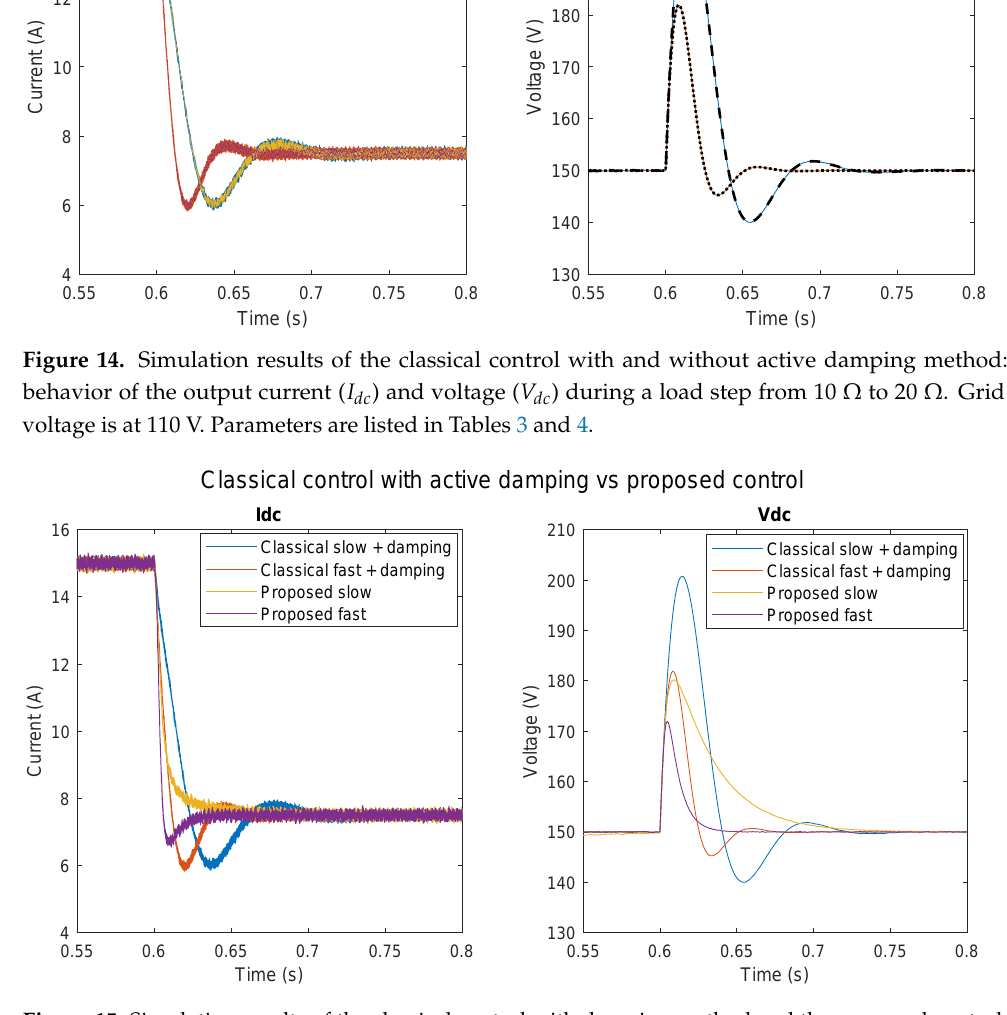
Figure 15. Simulation results of the classical control with damping method and the proposed control: behavior of the output current ( I dc ) and voltage ( V dc ) during a load step from 10 Ω to 20 Ω . Grid voltage is at 110 V. Parameters are listed in Tables 3 and